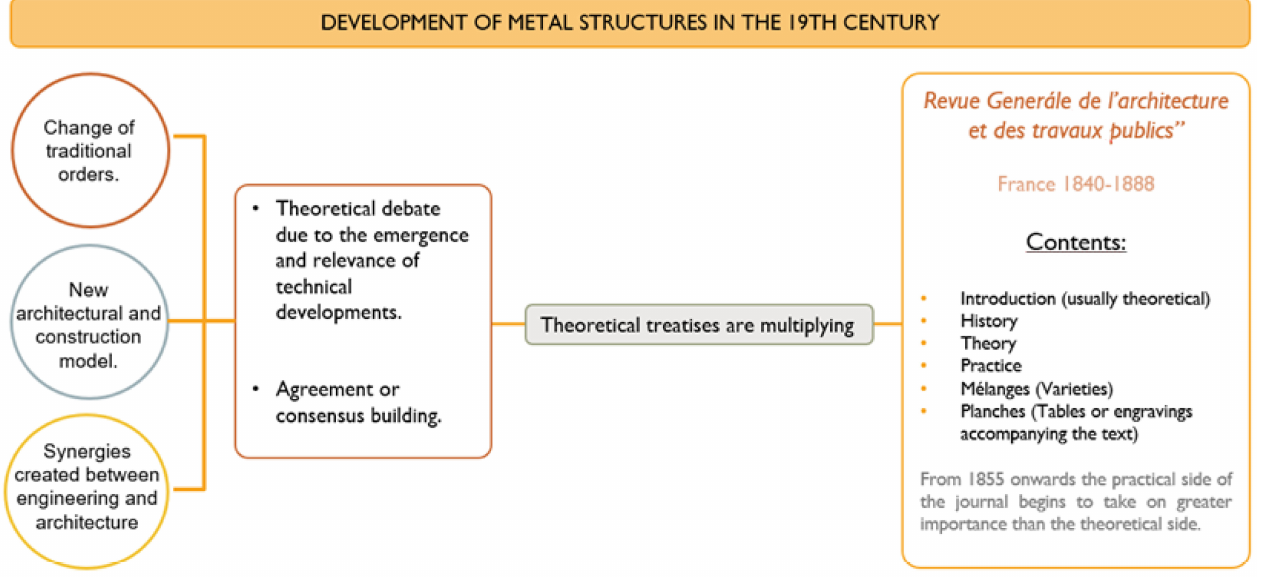
Figure 36. Outline of the constructive and theoretical development of 19th century architecture and engineering. Metal and its new forms as a defining material of contemporary